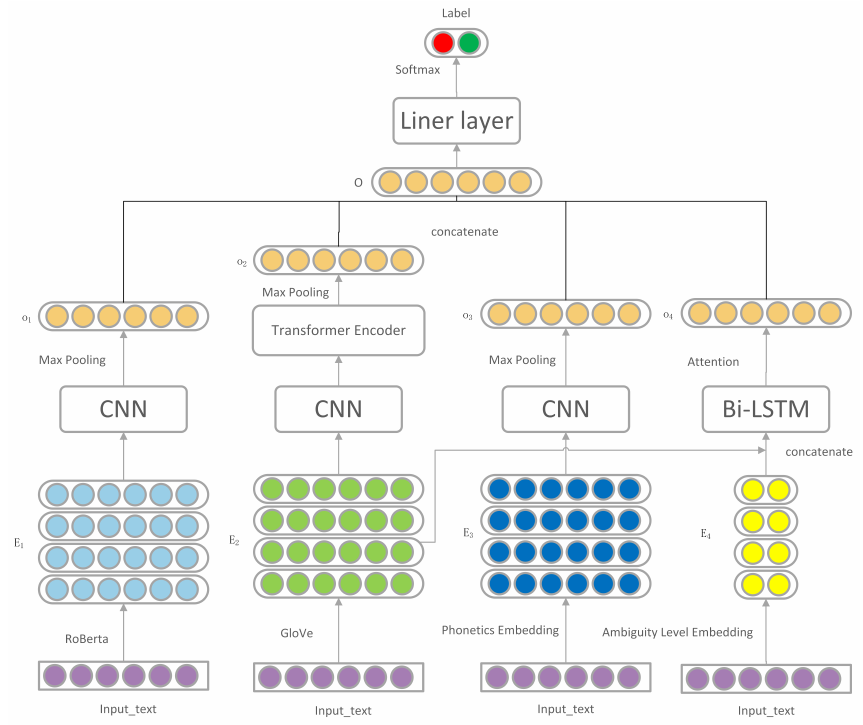
Figure 1. The framework diagram of the model consists of four parts: snippet embedding module, snippet semantic inconsistency module, voice feature module, and ambiguity